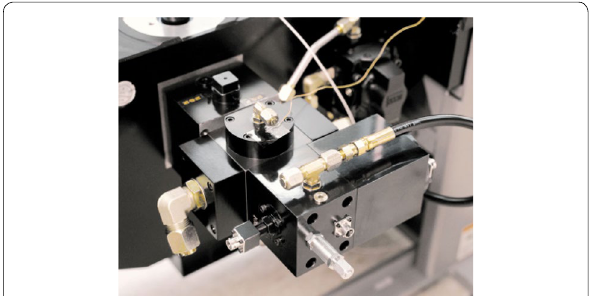
Figure 1 High-performance voice coil servo-valve